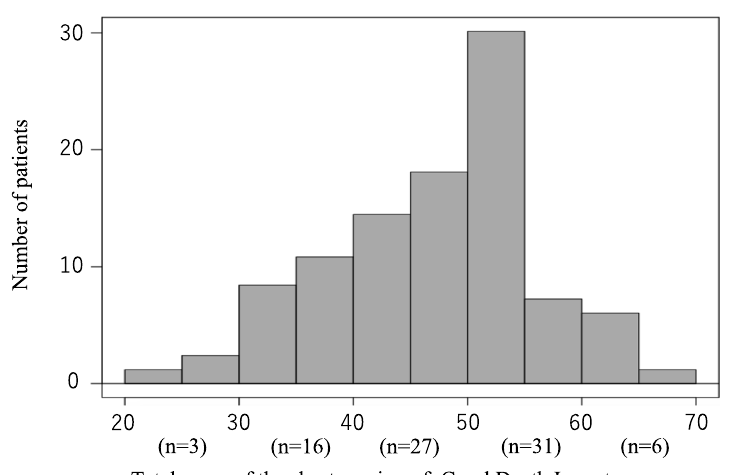
Fig. 2 Histogram of the short version of the GDI score. The horizontal axis represents the short version of the GDI score, and the vertical axis represents the number of